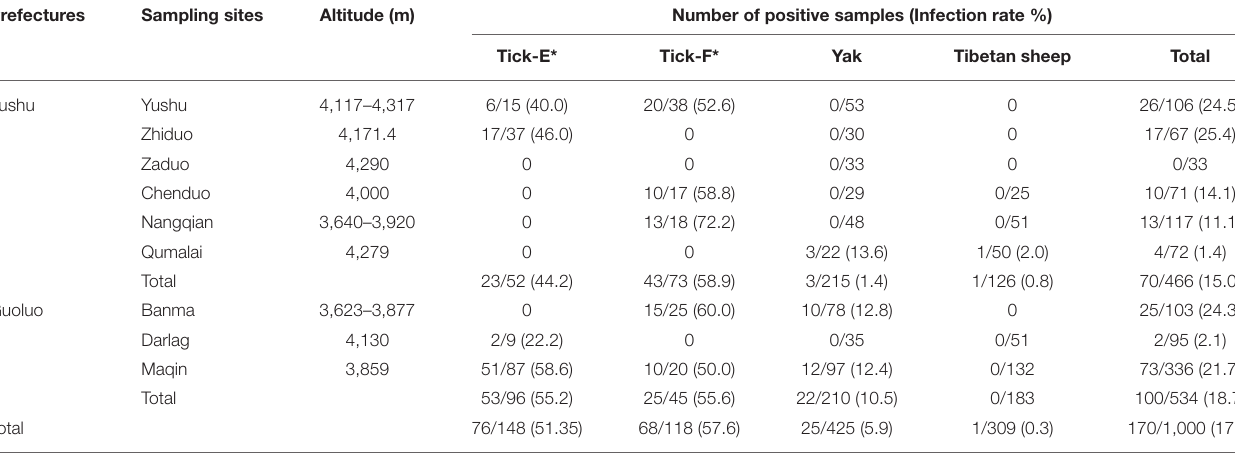
TABLE 2 | The positive samples of spotted fever group (SFG) Rickettsia in ticks and animals in this study. Prefectures